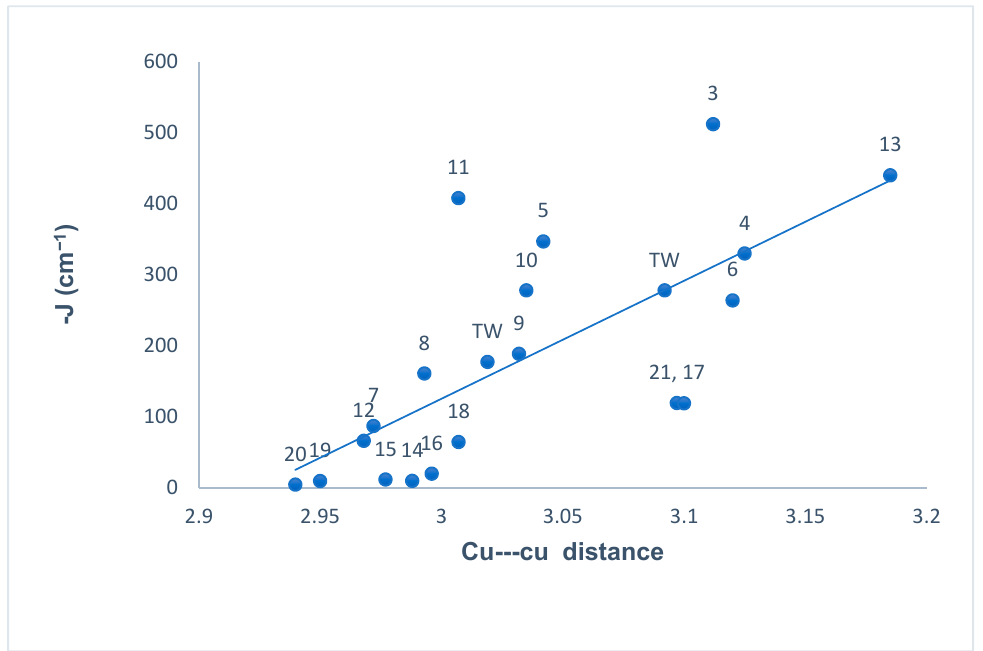
Figure 18. Plot of the antiferromagnetic interaction ( − J) vs. the Cu---Cu distance (d) in dinuclear ( μ -phenolate/ μ -azido bridged) copper(II) complexes.